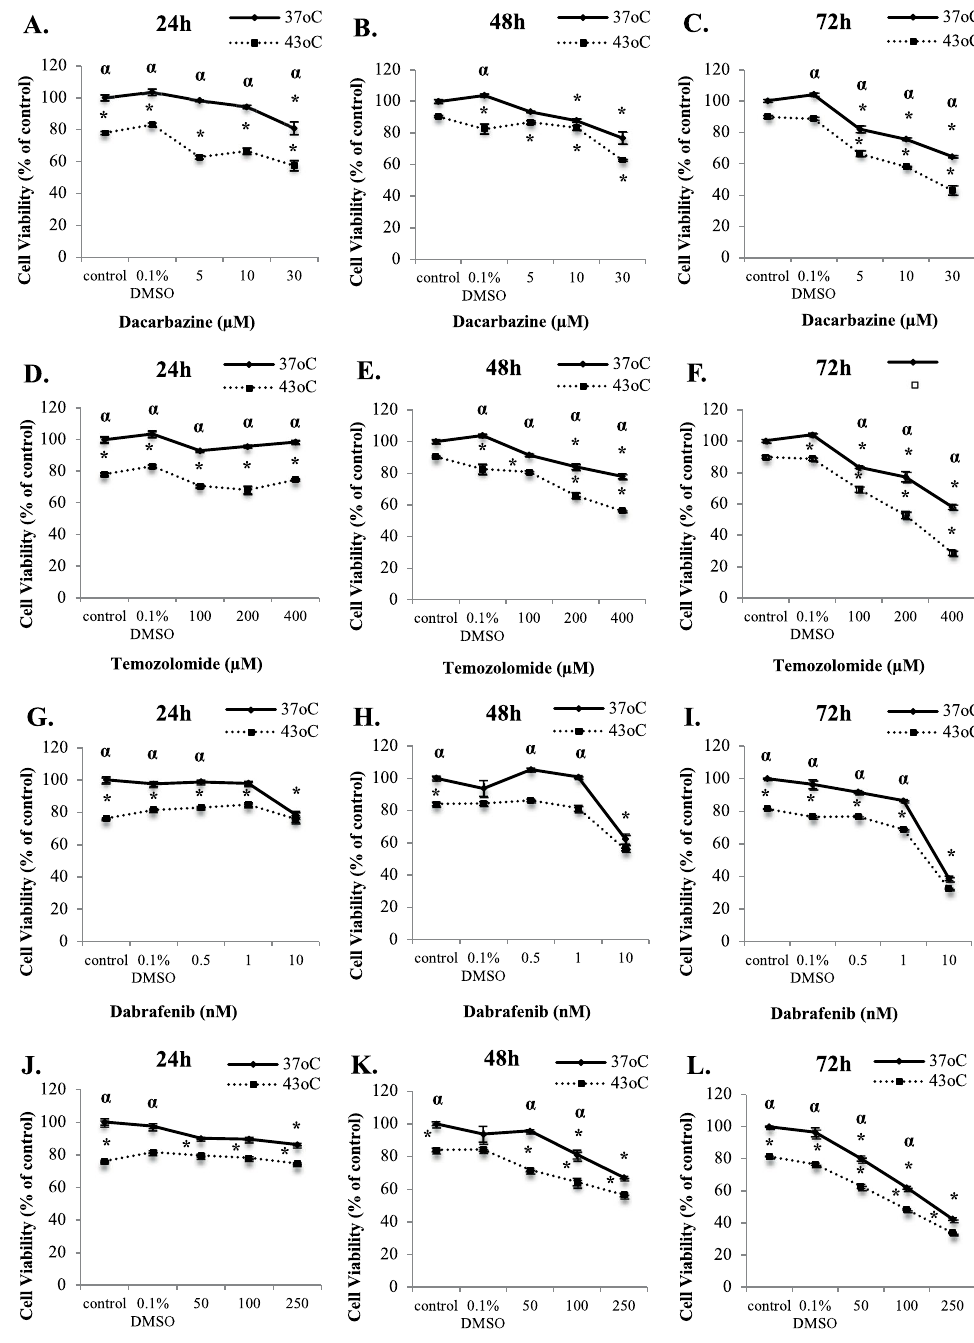
Figure 7. Hyperthermia-induced potentiation of therapeutic effectiveness of non-targeted and targeted drugs in malignant melanoma (A375) cells. Comparison of cell viability levels following treatment with Dacarbazine ( A – C ), Temozolomide ( D – F ), Dabrafenib ( G – I ) and Vemurafenib ( J – L ). The drug compounds were used either as single agents, at 37 °C, or in combination with 43 °C hyperthermia over a time-course of 24–72 h. Cell viability levels were calculated by comparison with 0.1% DMSO (vehicle) at 37 °C. Data represent mean values ± SEM (n = 5) and represent one of at least two independent experiments. Asterisk ( * ) indicates statistical significance at p < 0.05 for comparison with respective control at 37 °C or 0.1% DMSO at 37 °C. Alpha ( α ) indicates statistical significance at p < 0.05 for comparisons between 37 °C and 43 °C for each experimental